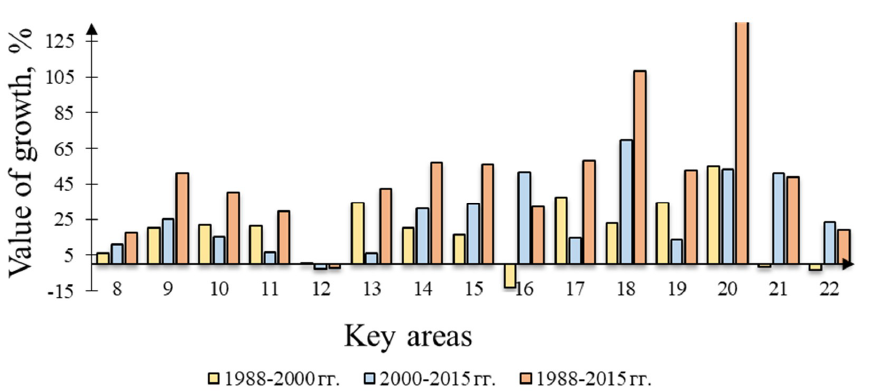
Figure 5. The dynamics of the horizontal dissection of the ephemeral gully network (the Samara River basin, Orenburg Region) for the periods 1988–2000, 2000–2015 and in general from 1988 to 2015.